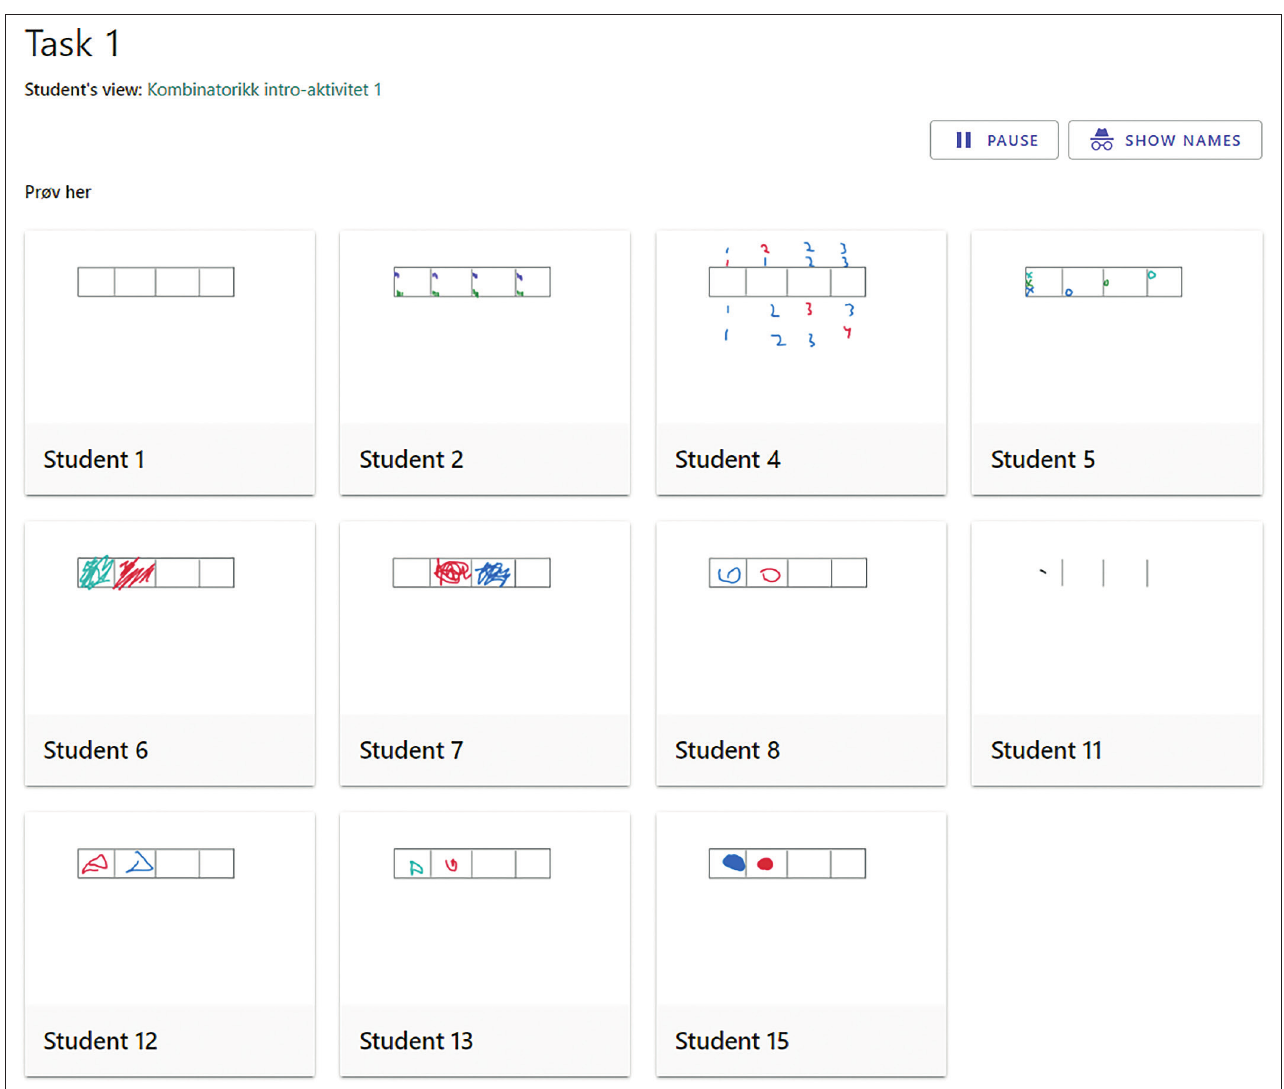
FIGURE 2-A2: After 4 minutes the task is